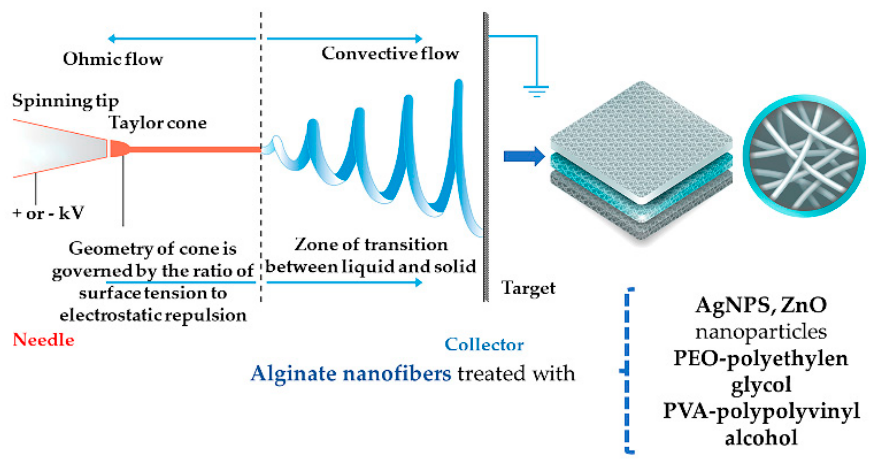
Figure 3. Electrospun ALG nanofibers.